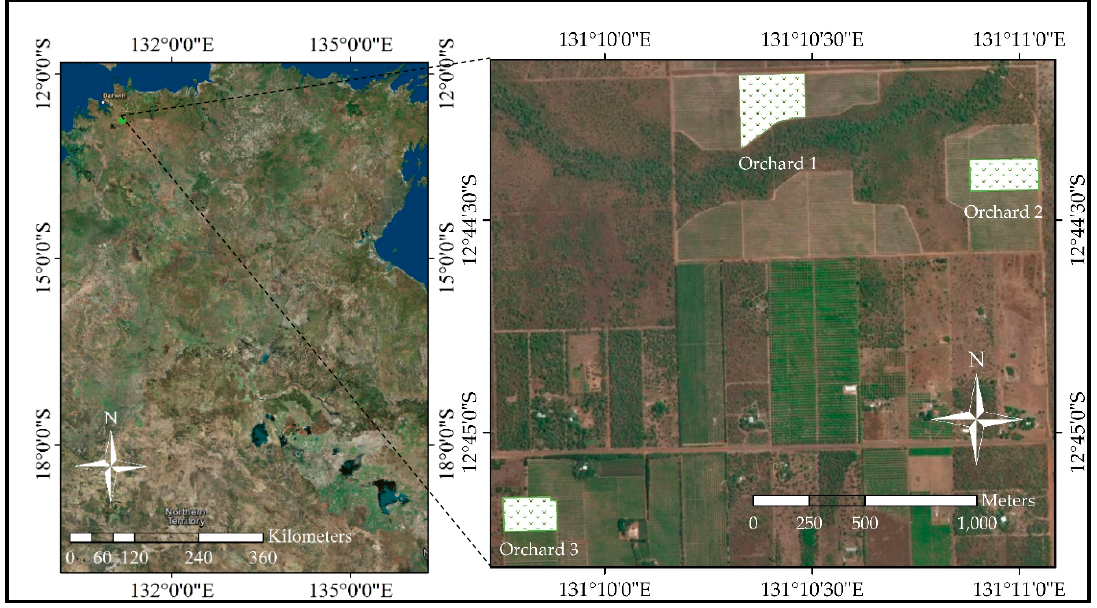
Figure 1. Location of the three mango orchards in Acacia Hills, Northern Territory, Australia. Three orchards are given the name Orchard 1, Orchard 2 and Orchard 3.